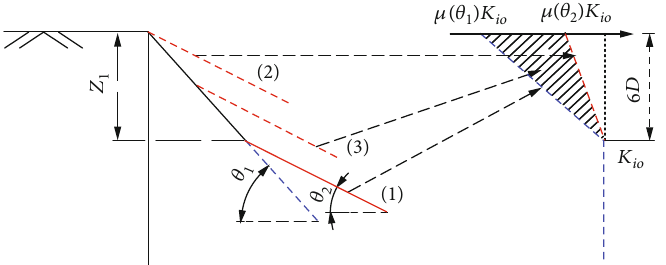
Figure 7: Initial sti ff ness model of concave sloping ground. (a) The concave sloping ground under 3 cases. (b) The value of initial sti ff ness under 3 cases.